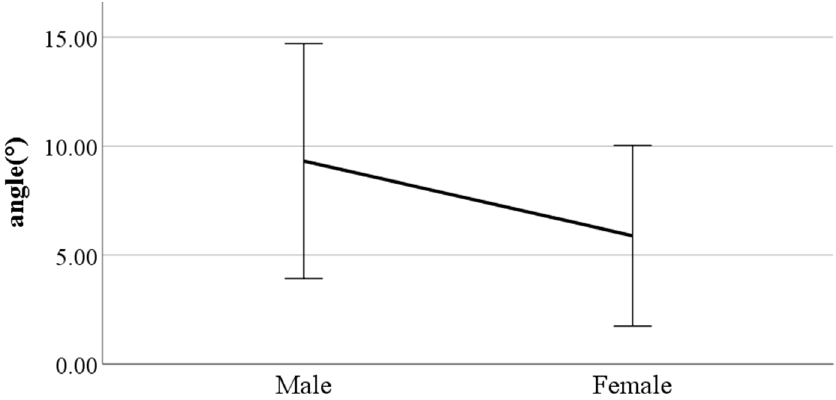
Figure 11. Gender difference in knee angle at heel-strike (F value: 2.39, DF: 289, p -value: 0.02).